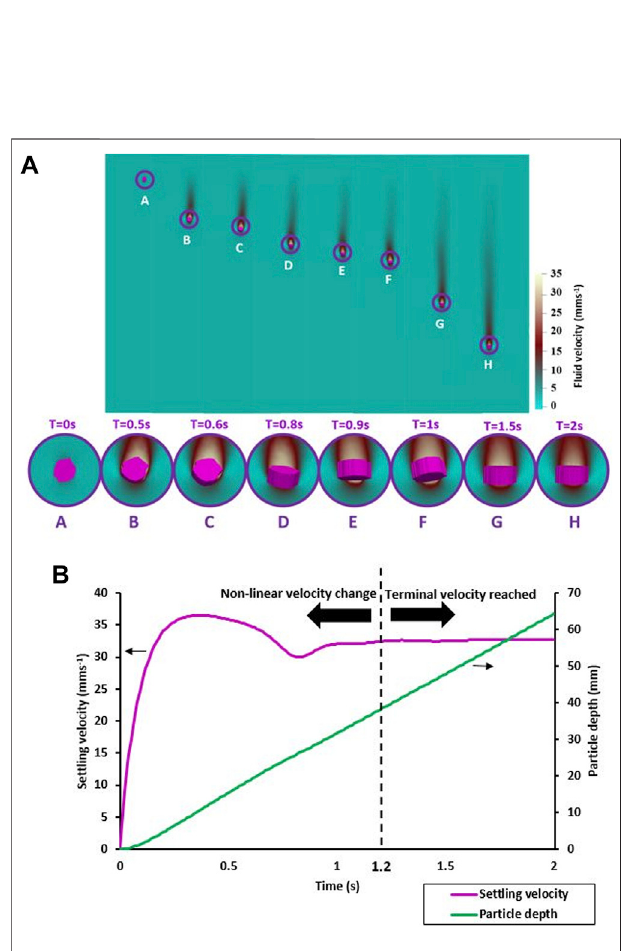
FIGURE4|(A) The fl uid velocity fi eldaroundoneofthe120irregular MP particles at different point in time. Insets A to F show stages of the transient phaseofsettling,whileinsetsGandHdepictthephaseaftertheTSVhasbeen reached. Initial water velocity is zero and once the particle starts settling, the fl uid velocity fi eld around the particle shows changes in water velocity, whilethevelocityofthewaterinimmediatecontactwiththeparticlere fl ectsthe settling velocity of the particle itself. (B) Velocity and particle